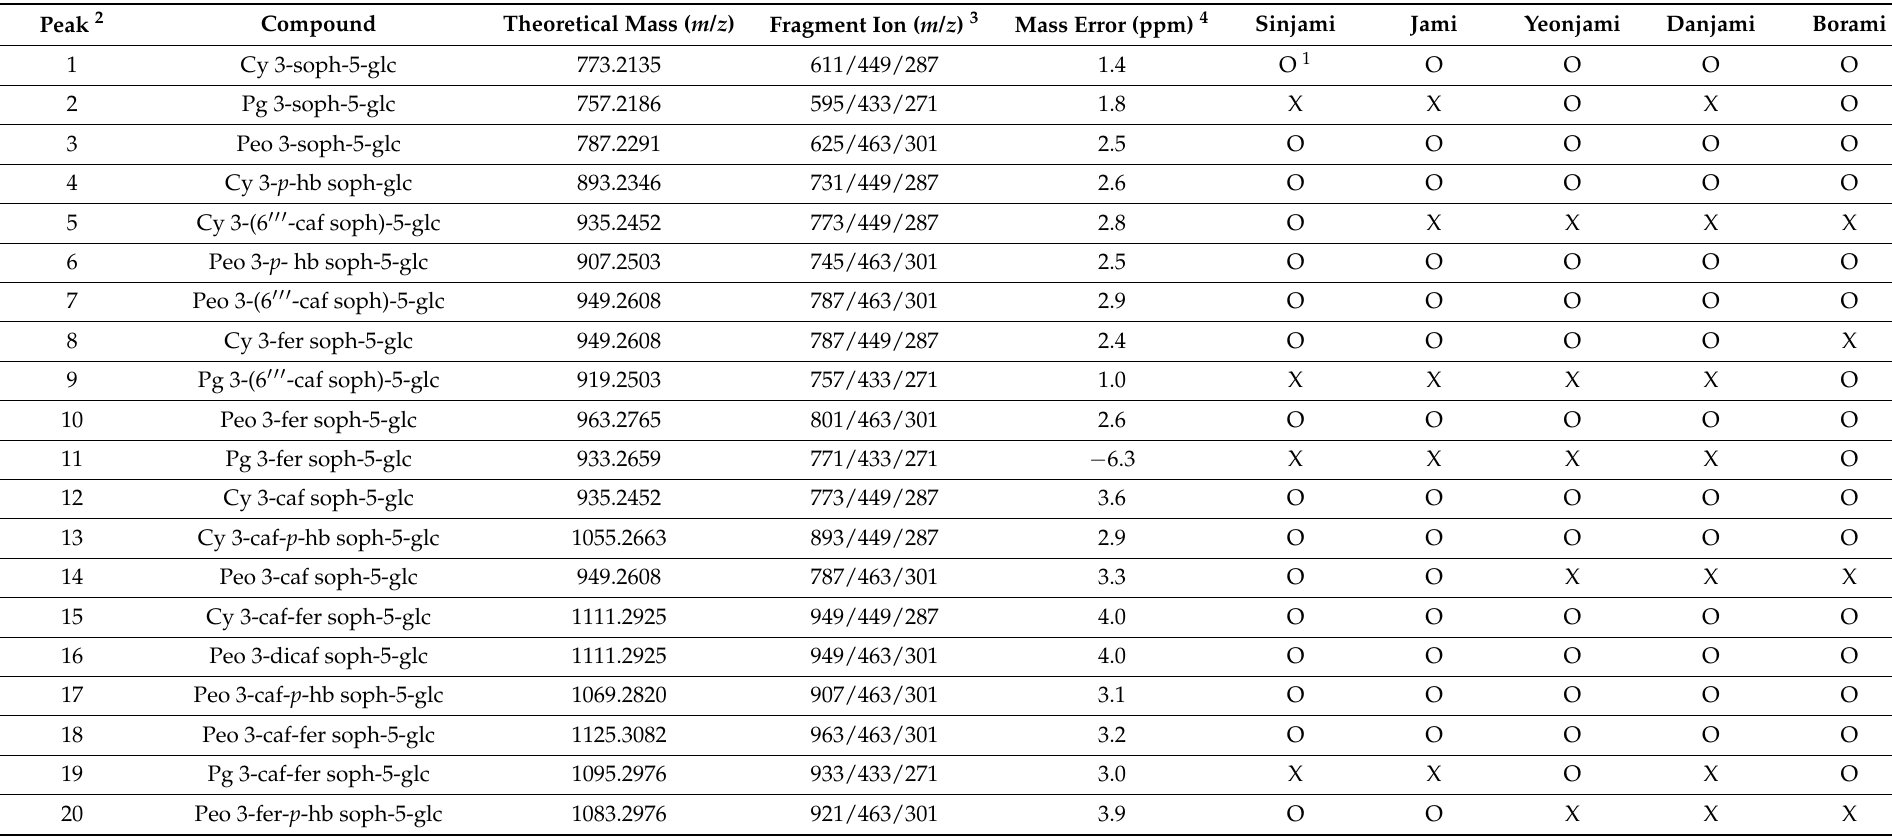
Table 1. Identified anthocyanins in purple sweet potato using an ultra-high-performance liquid chromatography-positive electrospray-time-of-flight mass spectrometer (UHPLC-(ESI)- qTOF